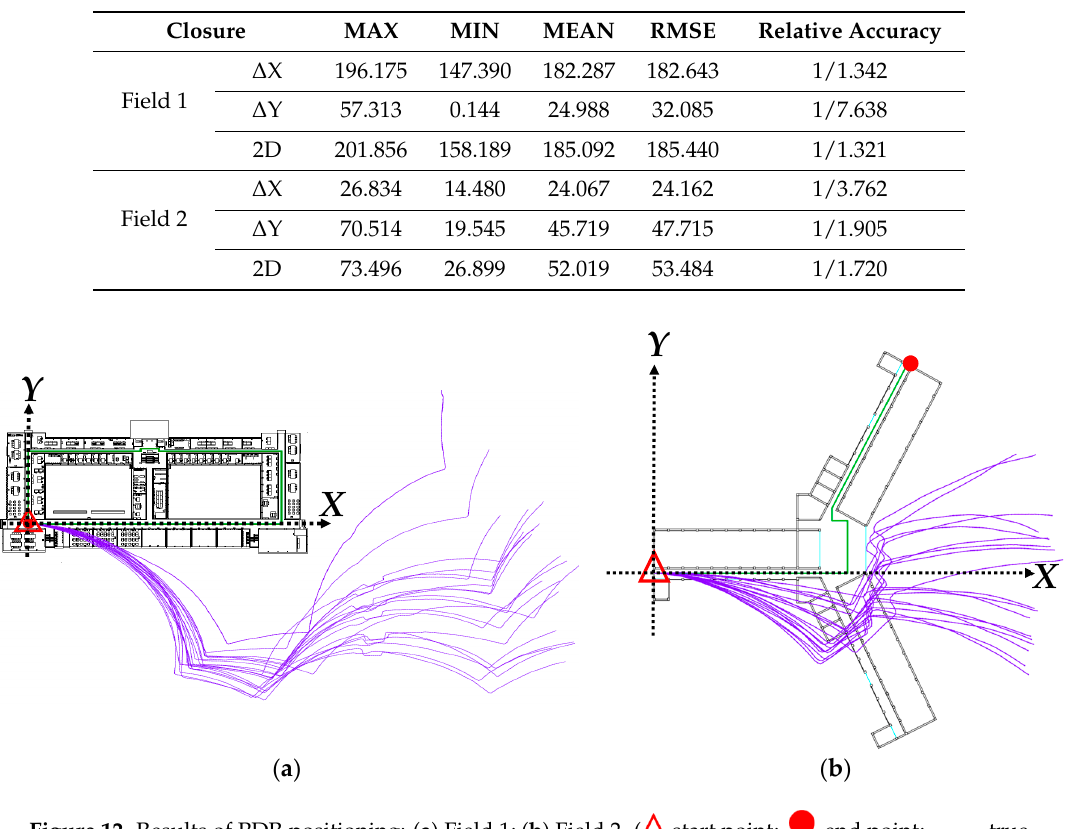
Table 4 . Statistics of PDR positioning (unit: m) .